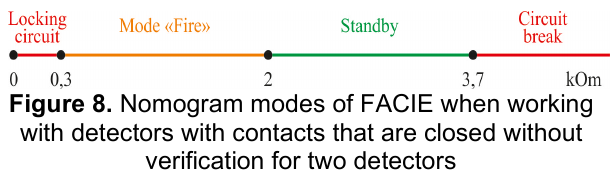
Figure 8. Nomogram modes of FACIE when working with detectors with contacts that are closed without verification for two detectors